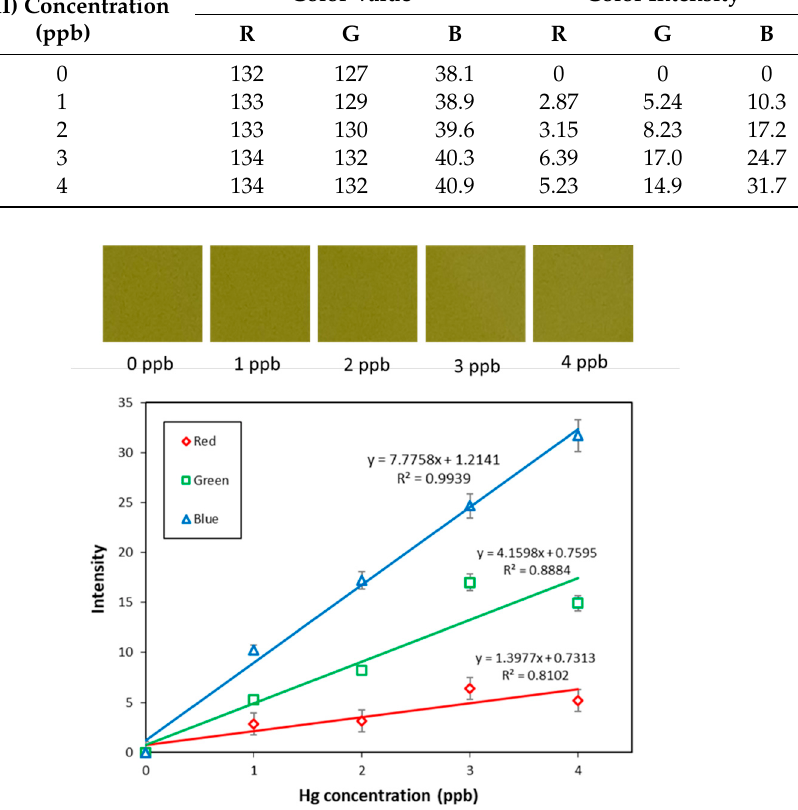
Figure 3. The cropped digital image of standard solutions containing 1 to 4 ppb mercury ions, and the corresponding calibration curve with blue color as the complementary color of the yellowish brown color of AgNPs that gives the highest slope. Error bars were calculated from three replicates.